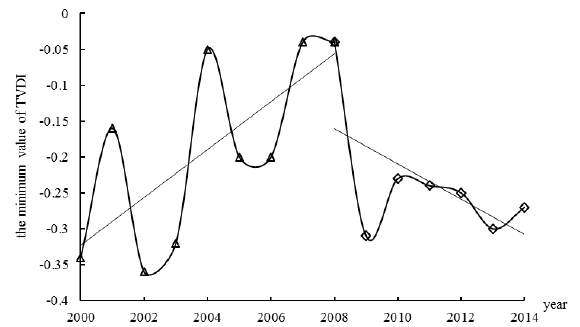
Figure 5. Variation of the minimum TVDI during 2000 to 2014